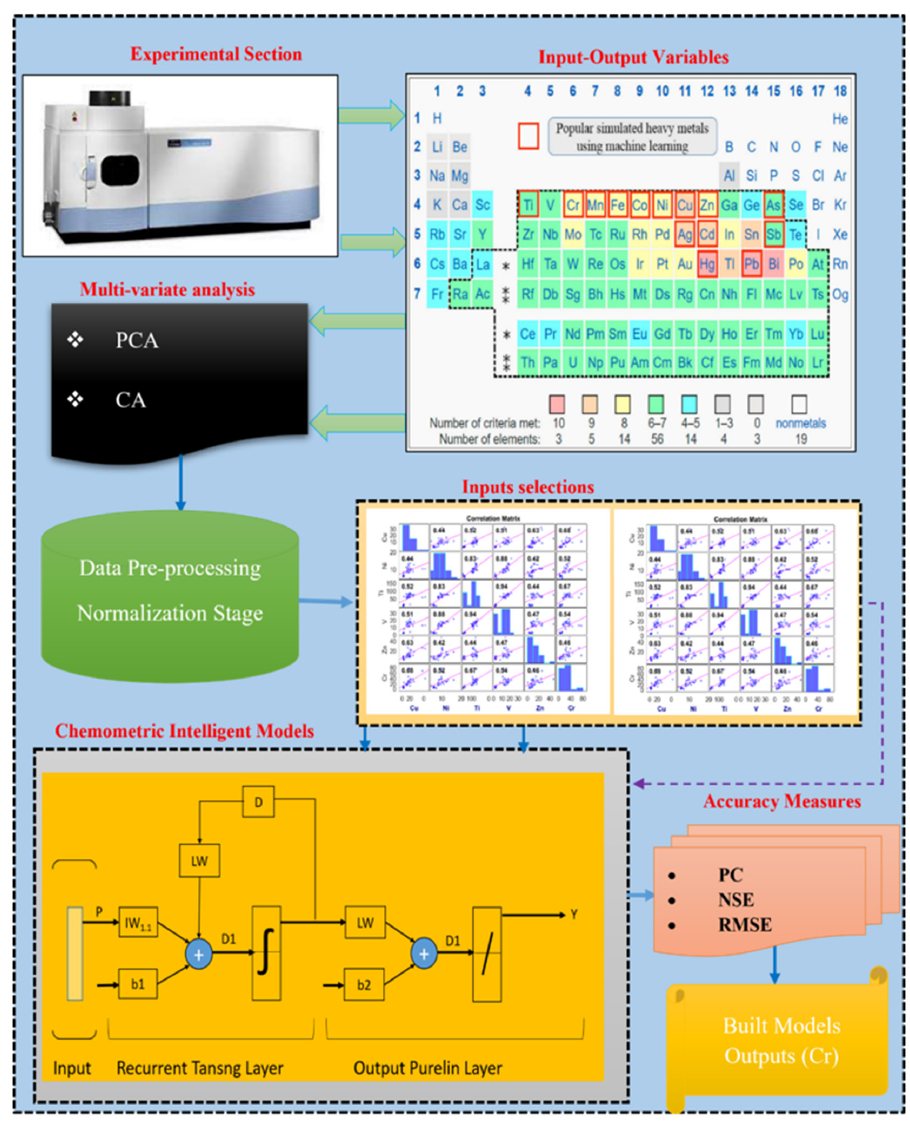
Figure 4. Proposed methodology adopted in this study.